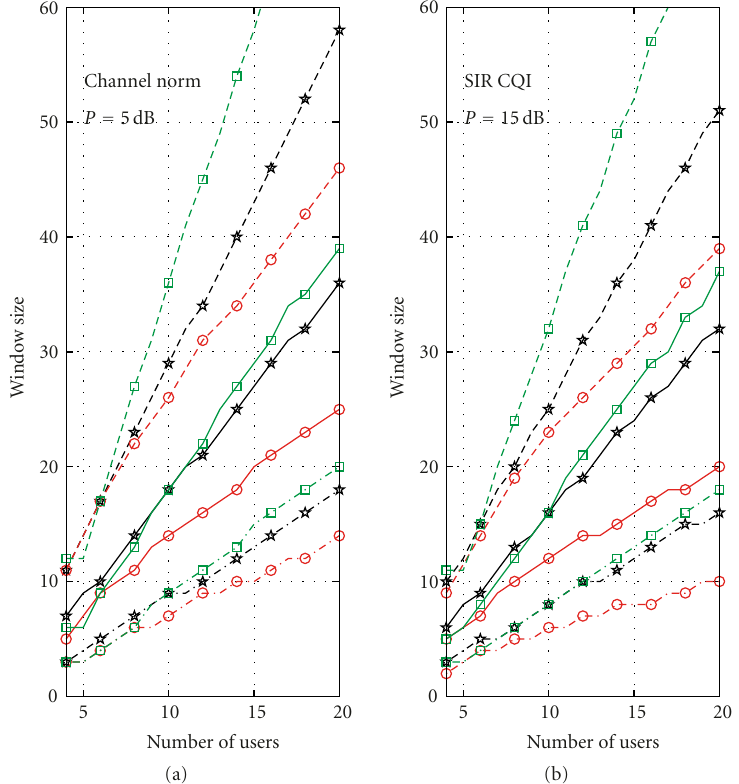
Figure 8: Required window size to achieve short-term throughput fairness with two-antenna mode 1 in the presence of Rayleigh fading, constant Tx power, and both CQI definitions. Curves with circles (“ ◦ ”), stars (“ (cid:3) ”) and squares (“ (cid:6) ”) refer to pure ORR, TDMA-RR and ORR-CQI, respectively. In all cases, dash-dotted curves represent a fairness index of 0 . 8, solid lines correspond to a fairness index of 0 . 9, and dashed curves refer to a fairness index of 0 .